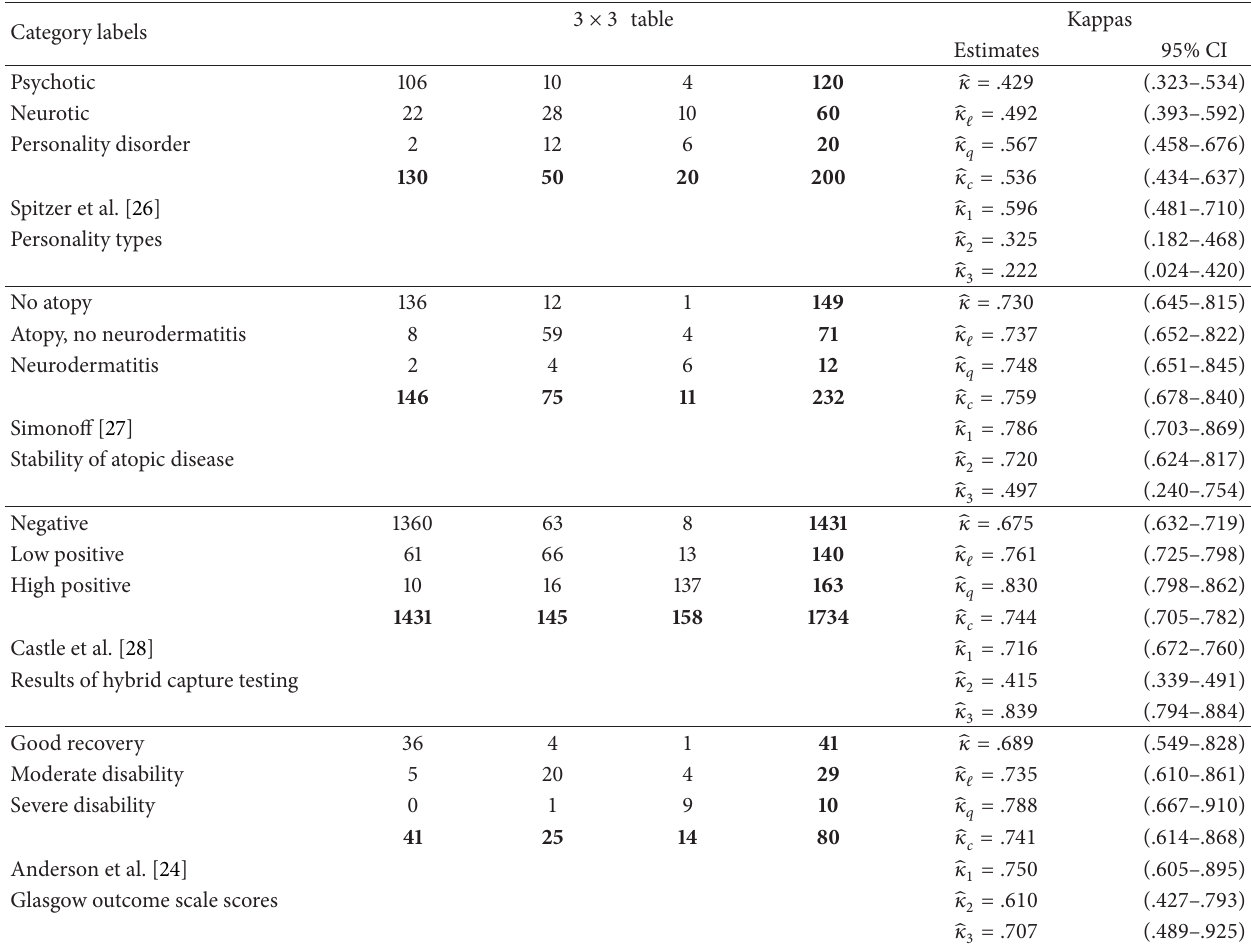
Table 2: Four examples of 3 × 3 agreement tables from the literature with corresponding values of weighted